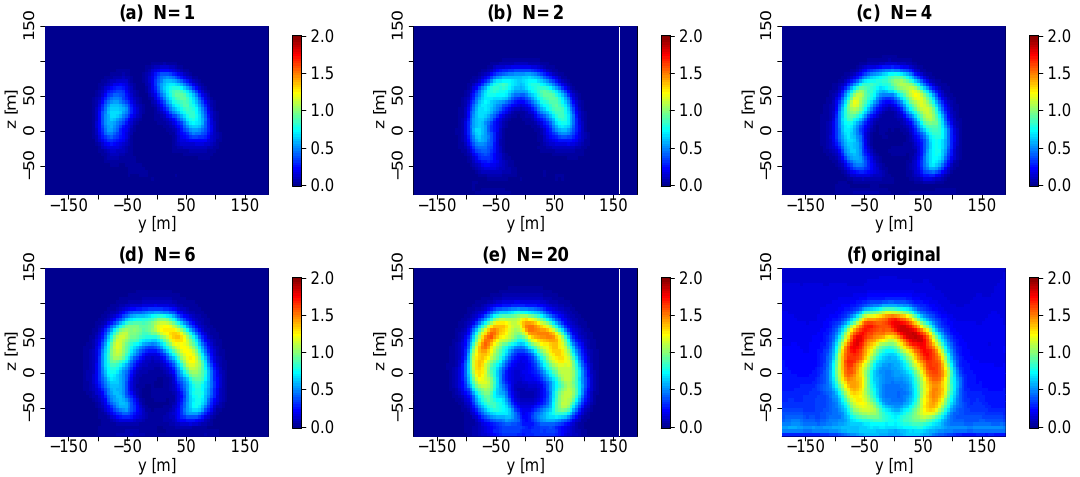
Figure 8. Local SKE (cid:104) u (cid:48) ( y , z ) 2 (cid:105) t ( m 2 s − 2 ) for original LES and truncated PODs including different numbers of modes N